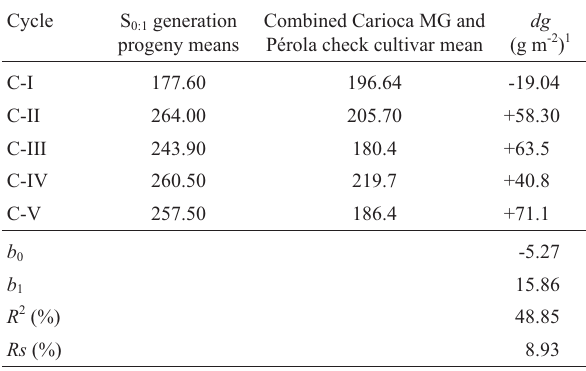
Table 6 - The S 0:1 generation progeny means from the first to the fifth recurrent selection cycle (C-I to C-V), the combined Carioca MG and Pérola check cultivar mean, the genetic deviation ( dg ) for the combined Carioca MG and Pérola check cultivar mean ( i.e. the progeny mean minus the combined Carioca MG and Pérola check cultivar mean), the intercept (